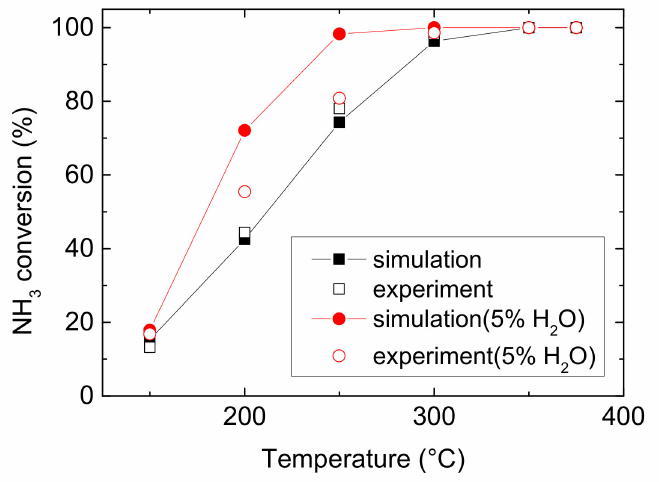
Figure 2. NH 3 conversion comparison of experimental and simulated results in 150–375 ◦ C